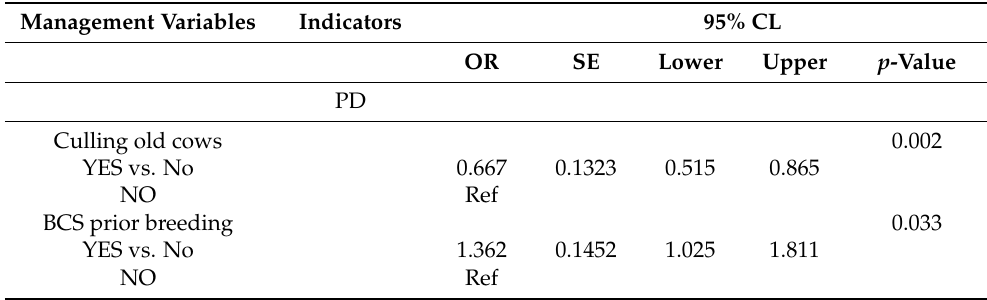
Table 9. Summary of association between management factors and the odds of performance in smallholder beef